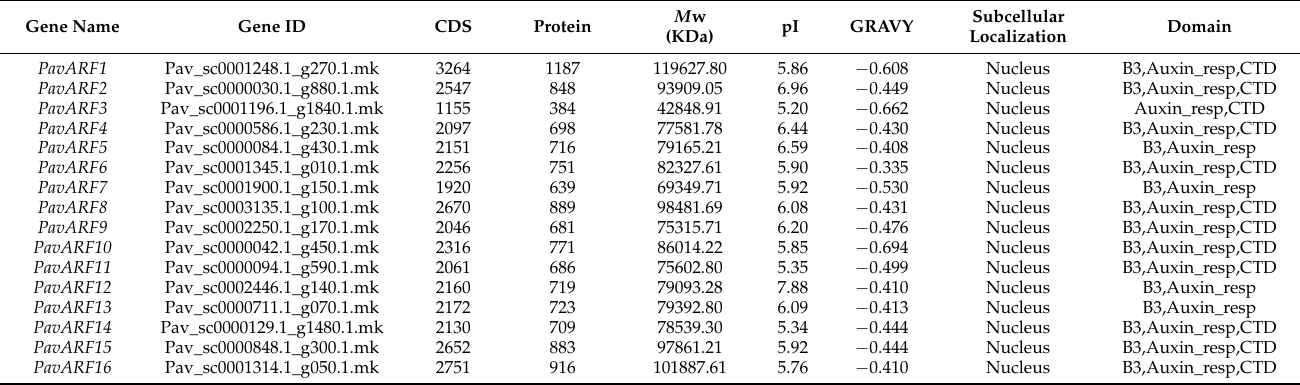
Table 1. Basic information of the ARFs gene family in sweet